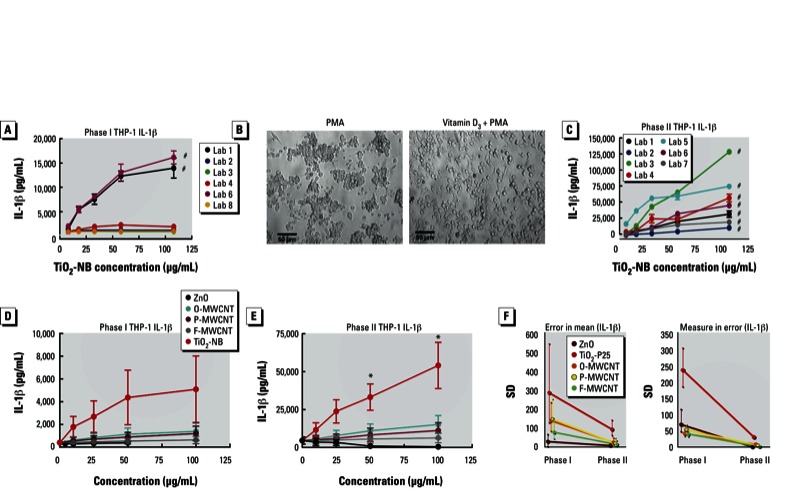
Phase I/II comparisons for THP-1 cells using IL-1β assay data. (A) Percent IL-1β release from THP-1 cells for each individual laboratory in phase I. (B) THP-1 cell differentiation technique altered cell morphology: THP-1 cells pretreated with 1.62 µM PMA for 24 hr formed clumps (left), whereas cells pretreated with vitamin D3 overnight and then treated with 5 nM PMA were evenly dispersed (right). (C) IL-1β release from THP-1 cells for each individual laboratory in phase II. (D,E) Summary IL-1β release for phase I conditions (D) and for phase II conditions (E). (F) Changes in error of the mean (left) and measure in error (right) from phase I to phase II trials for IL-1β assay data. Data are expressed as mean ± SE.
*p < 0.05 compared with other particles at the same concentration and/or the “no-particle” control. #p < 0.001 for dose response (each laboratory’s data analyzed independently).